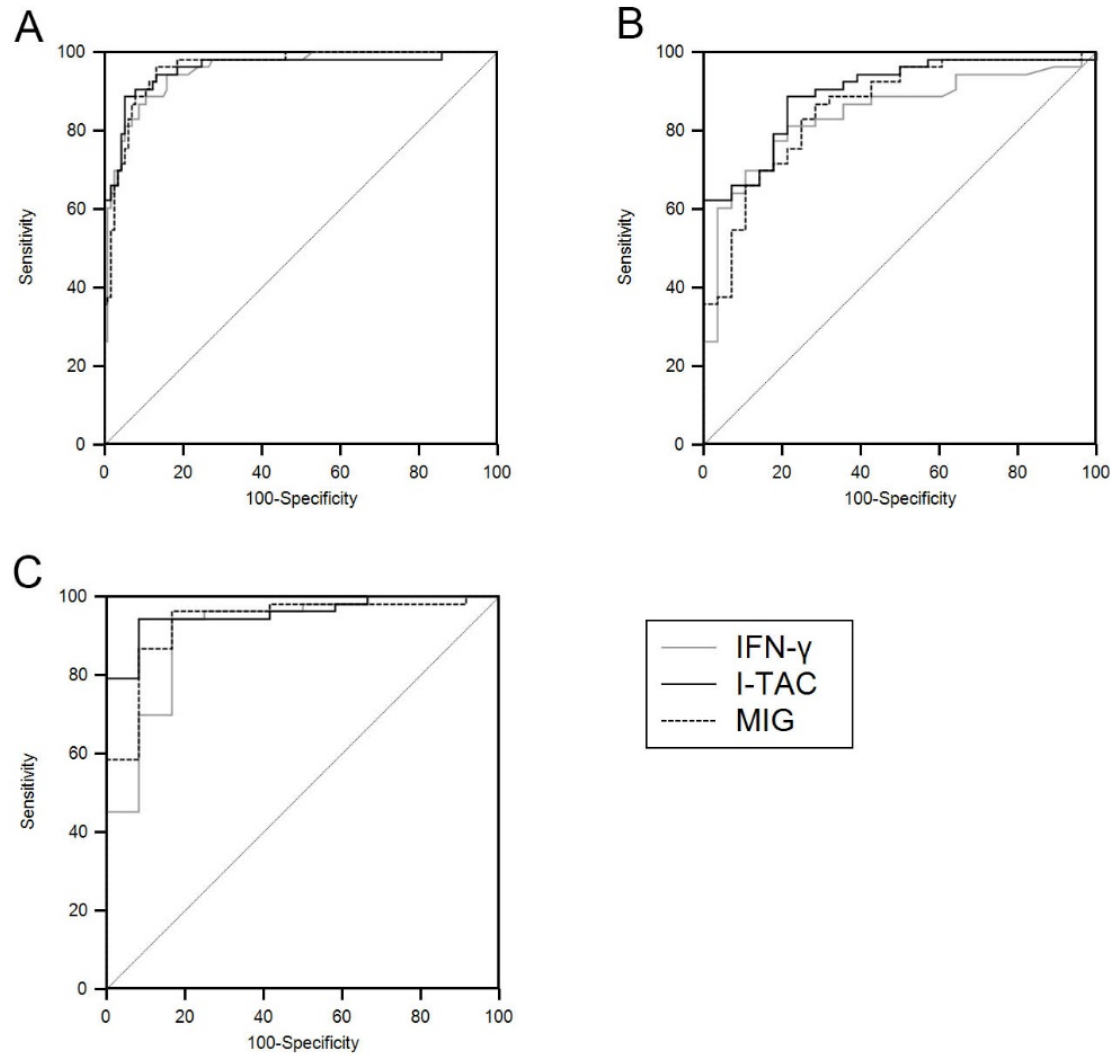
Figure 4. Receiver operating characteristic curves of interferon (IFN)- γ , IFN-inducible T-cell α –chemoattractant (I-TAC), and monokine induced by IFN- γ (MIG) for differentiating all tuberculous lymphadenitis patients from all controls ( A ), IFN- γ release assay-positive controls ( B ), and patients with non-tuberculous lymphadenitis ( C ). Table 5. Diagnostic performance of markers for differentiation of definite TB-LAP patients ( n = 39) from those in other groups. AUC 95%CI Cutoff Sensitivity Specificity TB-LAP vs. all Controls